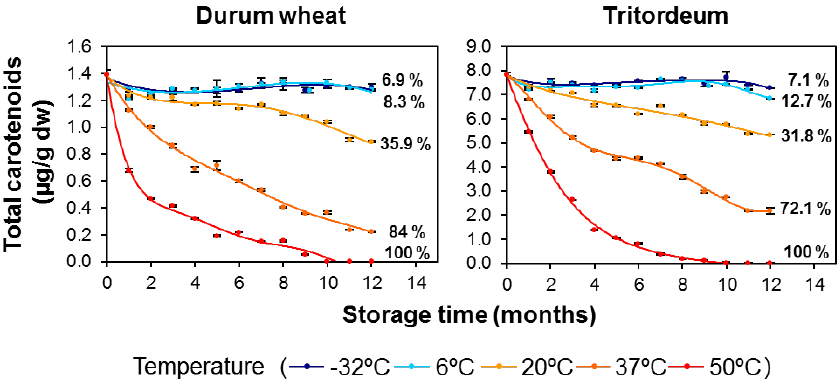
Figure 1. Evolution of the total carotenoid content (μg/g dry weight) in durum wheat (Don Pedro variety) and tritordeum (HT621 advanced line) whole-grain flours during long-term storage under temperature controlled conditions (−32, 6, 20, 37 and 50 °C). The values shown are the mean and standard error ( n = 5 for the starting sample, n = 3 for the rest of the samples). Pigment losses (%) are indicated at the end of storage.